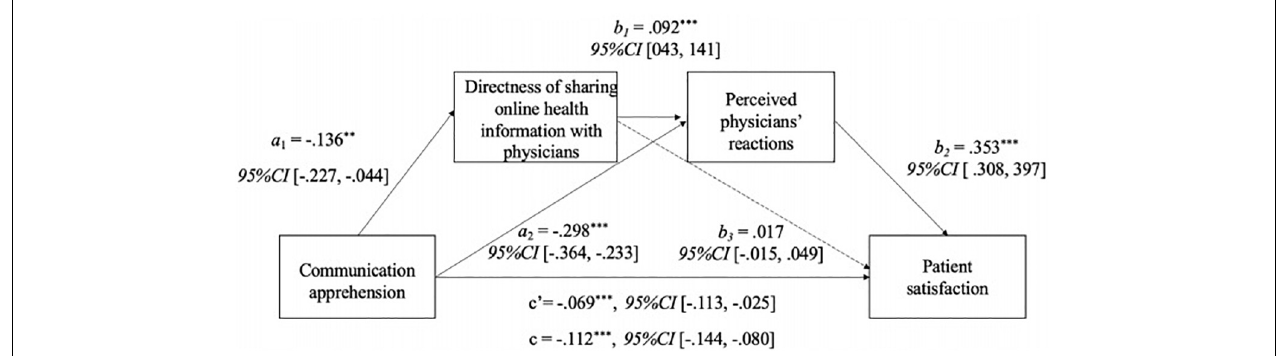
FIGURE 2 | The results for serial multiple mediation model with communication apprehension. Analyses are based on 5,000 bootstrap samples, controlling for sex, age, education level, and health status. Path coefficients are unstandardized coefficient. → significant paths; (cid:57)(cid:57)(cid:75) non-significant paths. Indirect effect (a 1 b 1 b 2 ): effect size = − 0.004, Boot SE = 002, 95% CI [ − 0.009, − 0.001]. Indirect effect (a 1 b 3 ): effect size = − 0.002, Boot SE = 003, 95% CI [ − 0.009, 0.002]. Indirect effect (a 2 b 2 ): effect size = − 0.105, Boot SE = 016, 95% CI [ − 0.137, − 0.074]. ∗∗ p < 0.01; ∗∗∗ p <